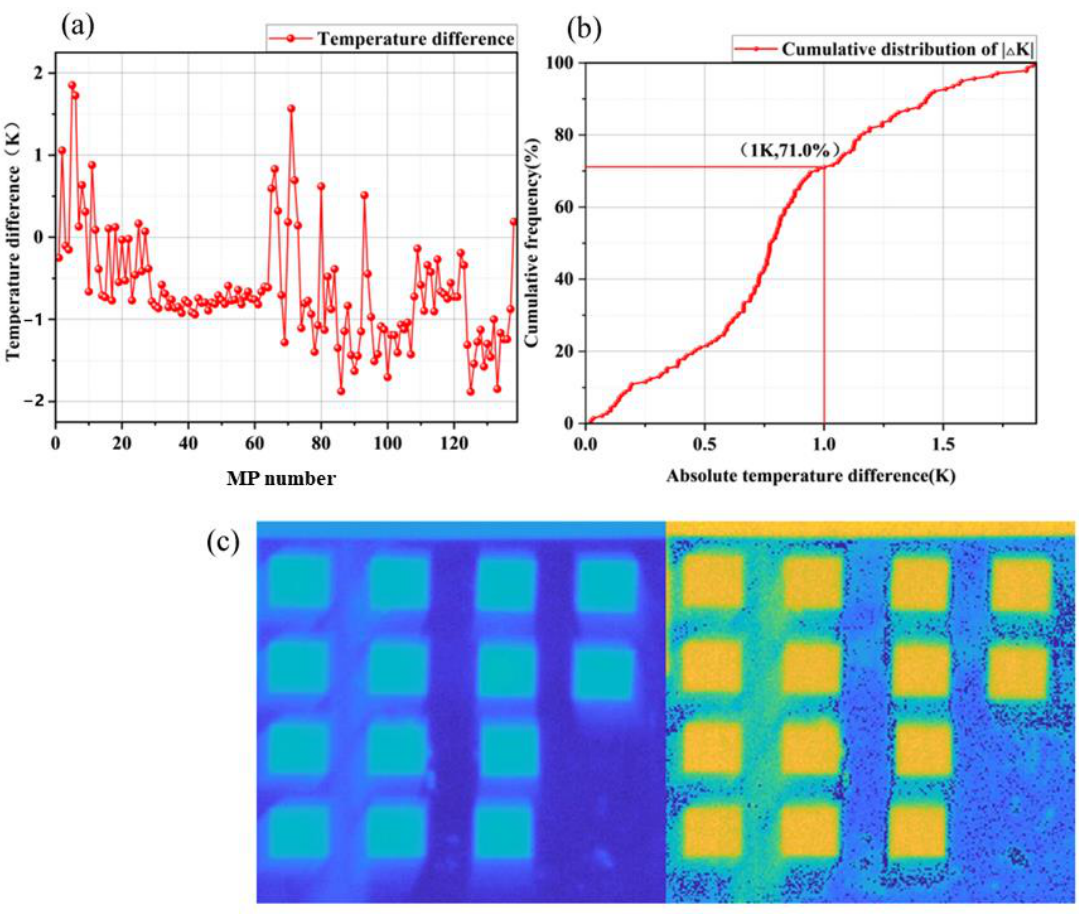
Figure 6. ( a ) Difference between the measured temperature and inverted temperature of 138 MP samples; ( b ) cumulative distribution of absolute temperature difference; ( c ) temperature profile of some MP samples.